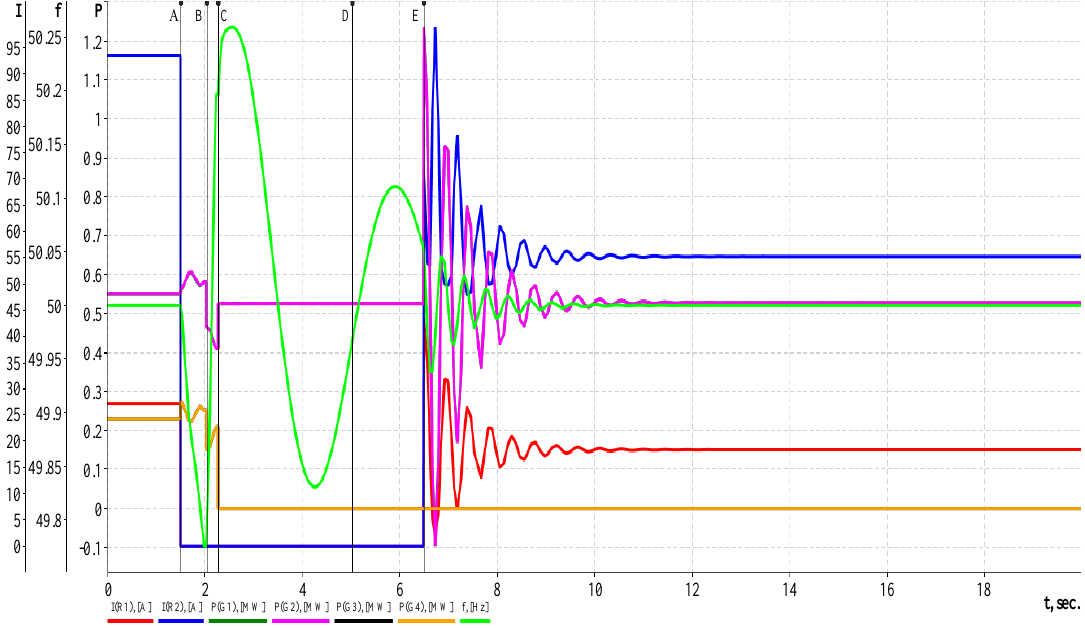
Figure 10. The microgrid transient response with 60% of the maximum load.